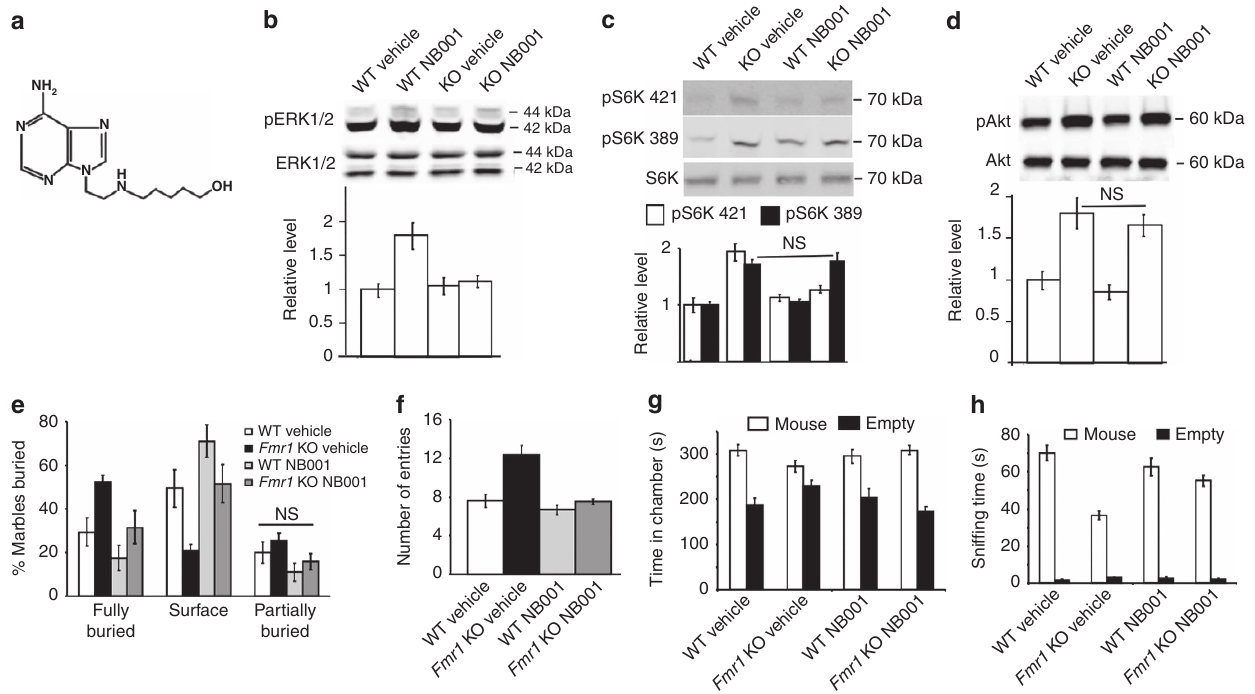
Figure 5 | Acute pharmacological inhibition of ADCY1 rescues the abnormal ERK1/2 activity and autism-related symptoms in Frm1 KO mice. ( a ) Molecular structure of NB001. ( b – h ) WT and Fmr1 KO mice received i.p. injection of NB001 (1mgkg (cid:2) 1 ) or vehicle. Biochemical or behavioural examinations were performed one hour after injection. ( b – d ) The levels of phosphorylated and total level of ERK1/2 ( b ), S6K1 ( c ) and Akt ( d ) in the hippocampus of WT and Fmr1 KO mice receiving vehicle or NB001 ( n ¼ 5 for each group) were determined by immunoblot. Representative immunoblot results are shown in the top panels, and quantifications are shown in the bottom panels. ( e ) Mice receiving vehicle (WT, n ¼ 9; Fmr1 KO, n ¼ 12) or NB001 (WT, n ¼ 9; Fmr1 KO, n ¼ 9) were examined by the marble burying test. ( f ) In light/dark test (WTvehicle n ¼ 11, Fmr1 KO vehicle n ¼ 13, WT NB001 n ¼ 10, Fmr1 KO NB001 n ¼ 15), number of entries to the lit chamber was recorded. ( g , h ) In the 3-chamber social interaction test (WT vehicle n ¼ 12, Fmr1 KO enclosure was recorded ( g ). Direct social interaction between the test mouse and the stimulus mouse was determined by the amount of sniffing time during the social interaction test ( h ). Detected by two-way ANOVA, NB001 corrected the elevated pERK ( F 1,16 ¼ 5.432, P ¼ 0.033 in b ) and pS6K421 ( F 1,16 ¼ 5.833, P ¼ 0.028 in c ), abnormal marble burying ( F 1,35 ¼ 4.124, P ¼ 0.041 for fully buried marbles; F 1,35 ¼ 4.12, P ¼ 0.041 for surface marbles in e ), light/dark behaviour ( F 1,45 ¼ 4.611, P ¼ 0.029 in f ) and abnormal direct social interaction ( F 1,42 ¼ 5.975, P ¼ 0.031 in h ) in Fmr1 KO mice. NS: not significant. Data are presented as mean ± s.e.m.